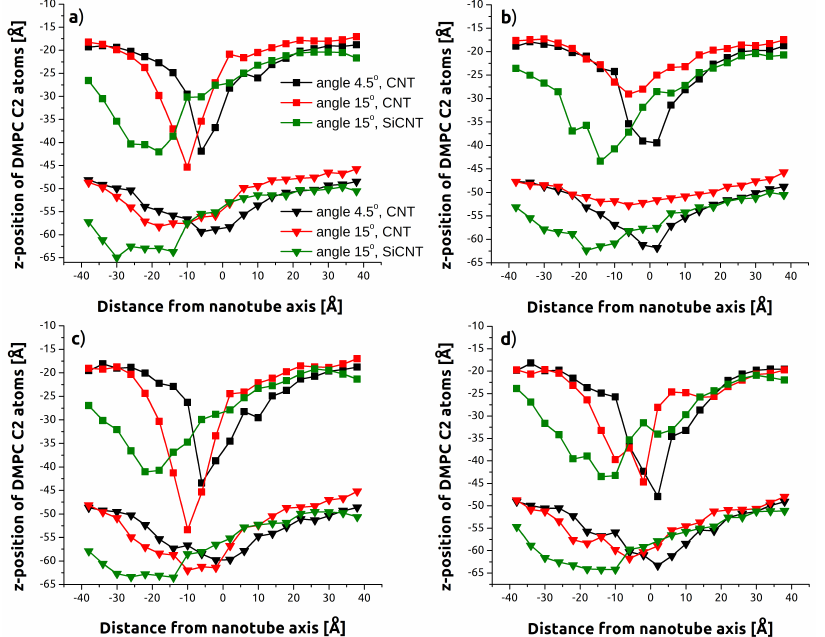
Figure 4. Average DMPC backbone C2 atom position at an indentation depth of z = − 55 to a resolution of 4 Å. Both the upper and lower layers are shown. ( a ) Low rate ( v = 0.5 m/s), tube-axis indentation. ( b ) Low rate ( v = 0.5 m/s), z -axis indentation. ( c ) High rate ( v = 2.0 m/s), tube-axis indentation. ( d ) High rate ( v = 2.0 m/s), z -axis